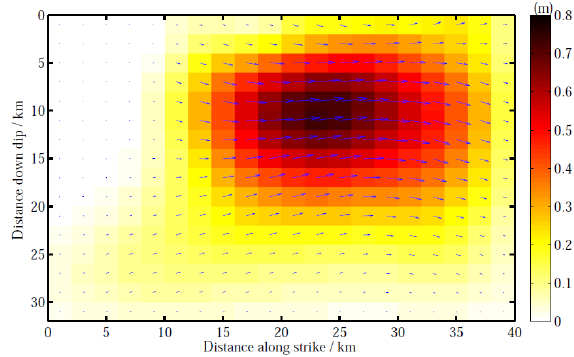
Figure 3. Slip model of Jiuzhaigou 7.0 Earthquake inverted from InSAR